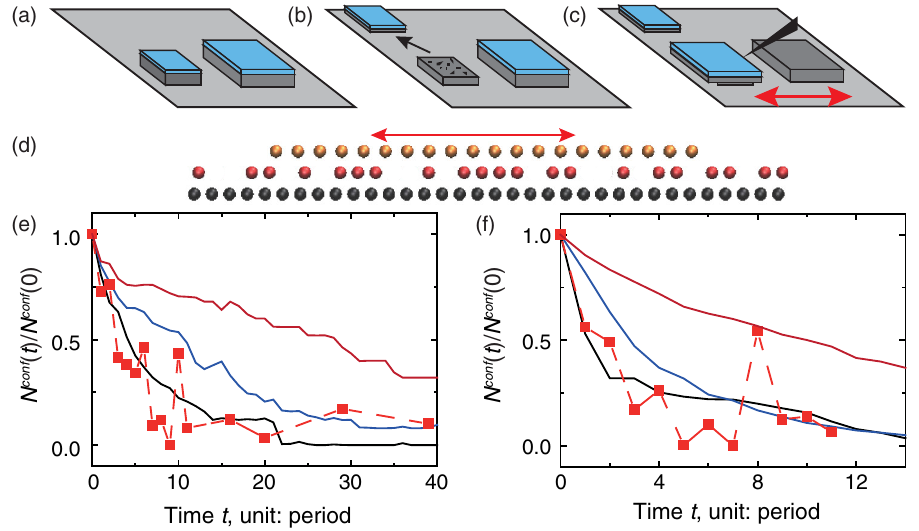
FIG. 6. Mechanical cleaning of surfaces. (a) – (c) Schematic representation of the experimental procedure including (a) preparation of graphite mesas, (b) adsorption of contaminants, and (c) transferring of the cover of the right mesa to the top of the left one and mechanical cleaning. The top parts in blue are SiO 2 , and the rest in gray are graphite mesas. The black triangle stands for the tip of the microforce sensing probe, and the red arrows indicate the direction of the oscillation of the substrate. (d) Schematic sketch of the model used to simulate the cleaning process via mechanical oscillation. Golden spheres represent the slider surface that oscillates as indicated by the arrows, red spheres show adsorbed particles, which initially are uniformly distributed, and black spheres depict the substrate. (e), (f) Comparison between the values of N conf ð t Þ =N conf ð 0 Þ measured in experiments (square symbols connected by dashed lines) and calculated in simulations (curves) for small ( A ∼ 0 . 1 L , where L is the size of the slider) and large amplitudes ( A ∼ 1 . 0 L ) of oscillations, respectively. In (e), the curves from top to bottom have been calculated for f=f 0 ¼ 1 . 26 × 10 − 2 , 5 . 03 × 10 − 5 , and 1 . 26 × 10 − 5 , respectively. In (f), the curves from top to bottom correspond to f=f 0 ¼ 1 . 26 × 10 − 2 , 1 . 26 × 10 − 3 , and 5 . 03 × 10 − 5 , respectively. Simulations have been performed for incommensurate surfaces with a